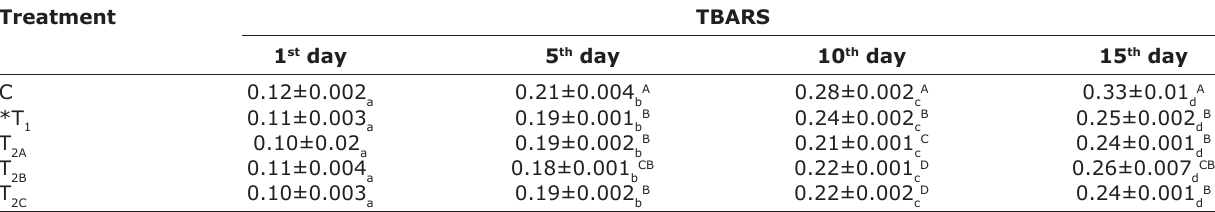
Table-3: Effect of CS and LS on TBARS values (mg MDA/kg) of pork sausages at different storage periods (mean±SE).